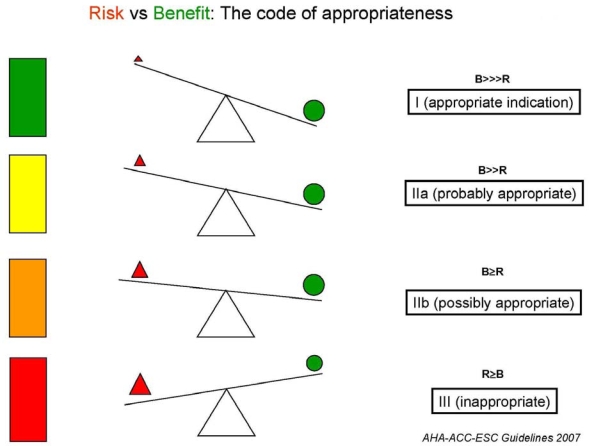
The balance between risks (red triangle) and benefits (green circles) determining the appropriateness score of testing. The three corners of the red triangle represent acute, subacute, and long-term (radiation) risks. Acute risks occur within seconds and minutes (for instance, death or myocardial infarction during stress or cath); sub-acute risks within days or weeks (for instance, contrast-induced nephropathy); and long-term risks (due to cumulative exposure to ionizing radiation) after years or decades.